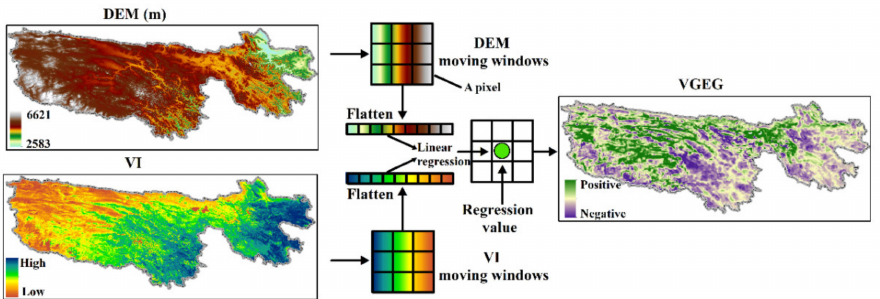
Figure 2. Diagrammatic sketch of the calculation of vegetation greenness along the elevation gradient (VGEG). Here, we take a 3 × 3 window as an